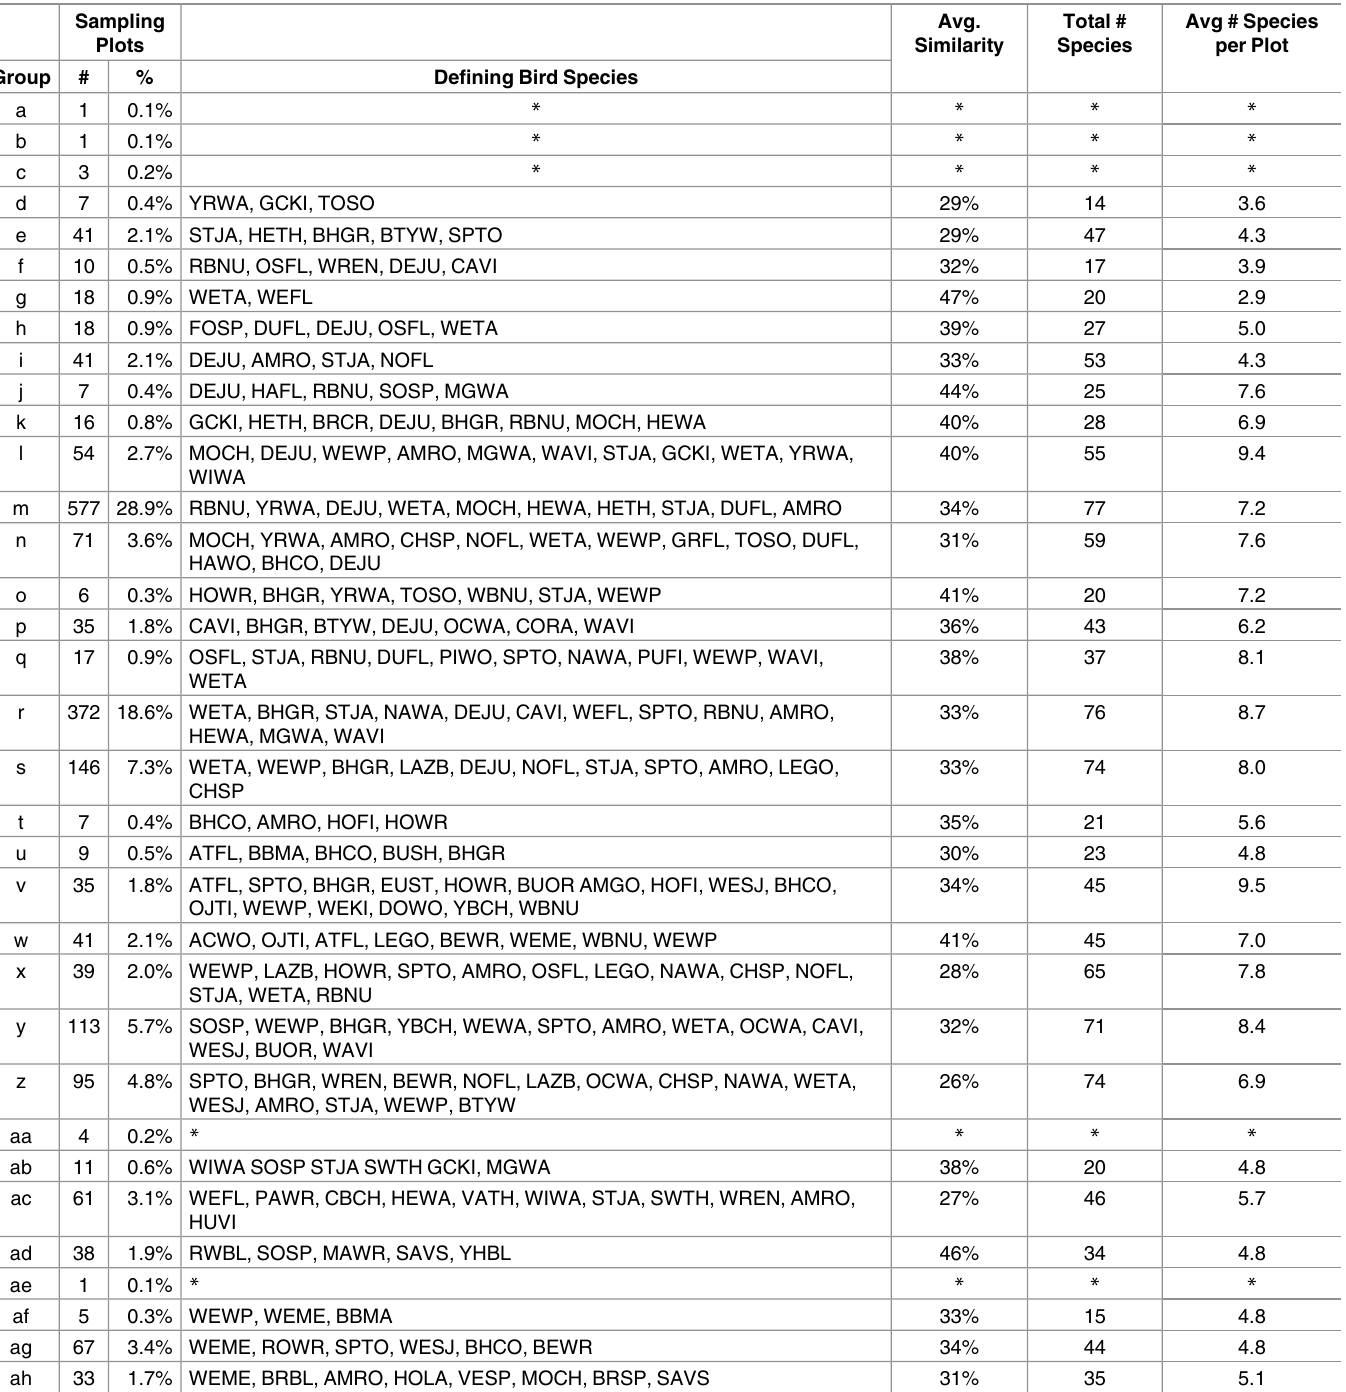
Table 1. Statistically Defined Bird Groups. Sampling